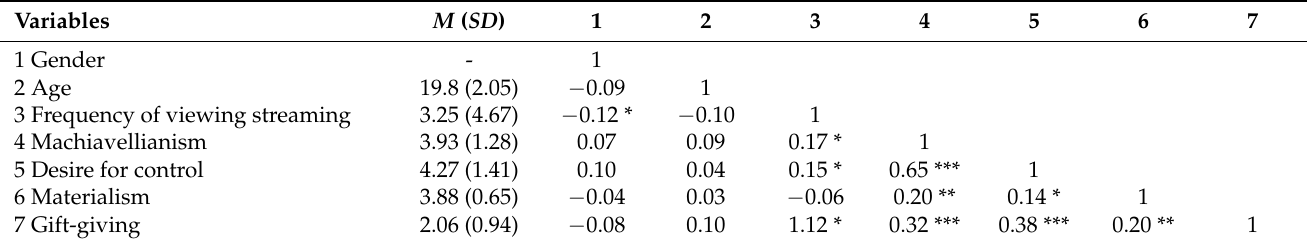
Table 1. Means, standard deviations, and correlation results.